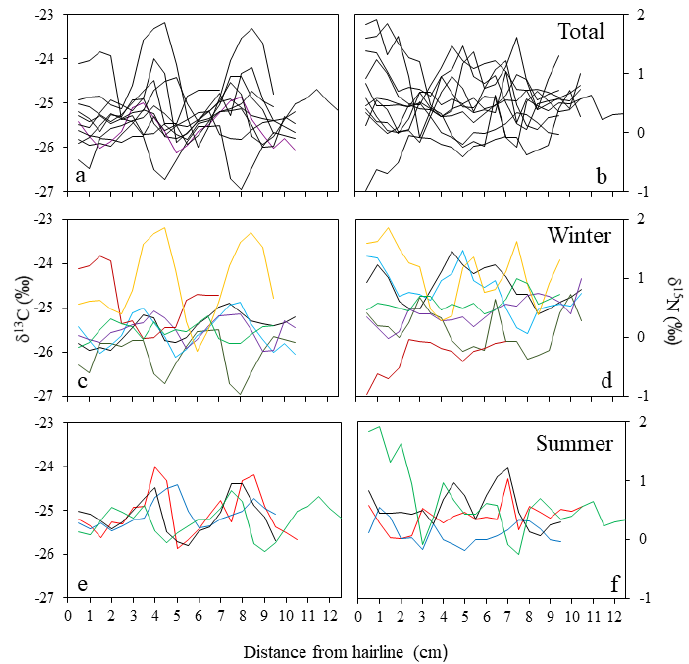
Figure 5. Variation in δ 13 C ( a , c , e ) and δ 15 N ( b , d , f ) along hooves from adult female moose that died during the winter ( c , d , n = 7) and the summer ( e , f , n = 4) from starvation or predation at Isle Royale National Park, USA. Hooves were sampled in 0.5-cm increments from the hairline to the tip. Di ff erent colors correspond to individual